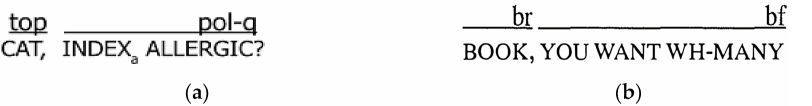
Figure 10. Notation strategies for phrases. ( a ) As for cats, is s/he allergic to them? ( b ) As for books, how many do you